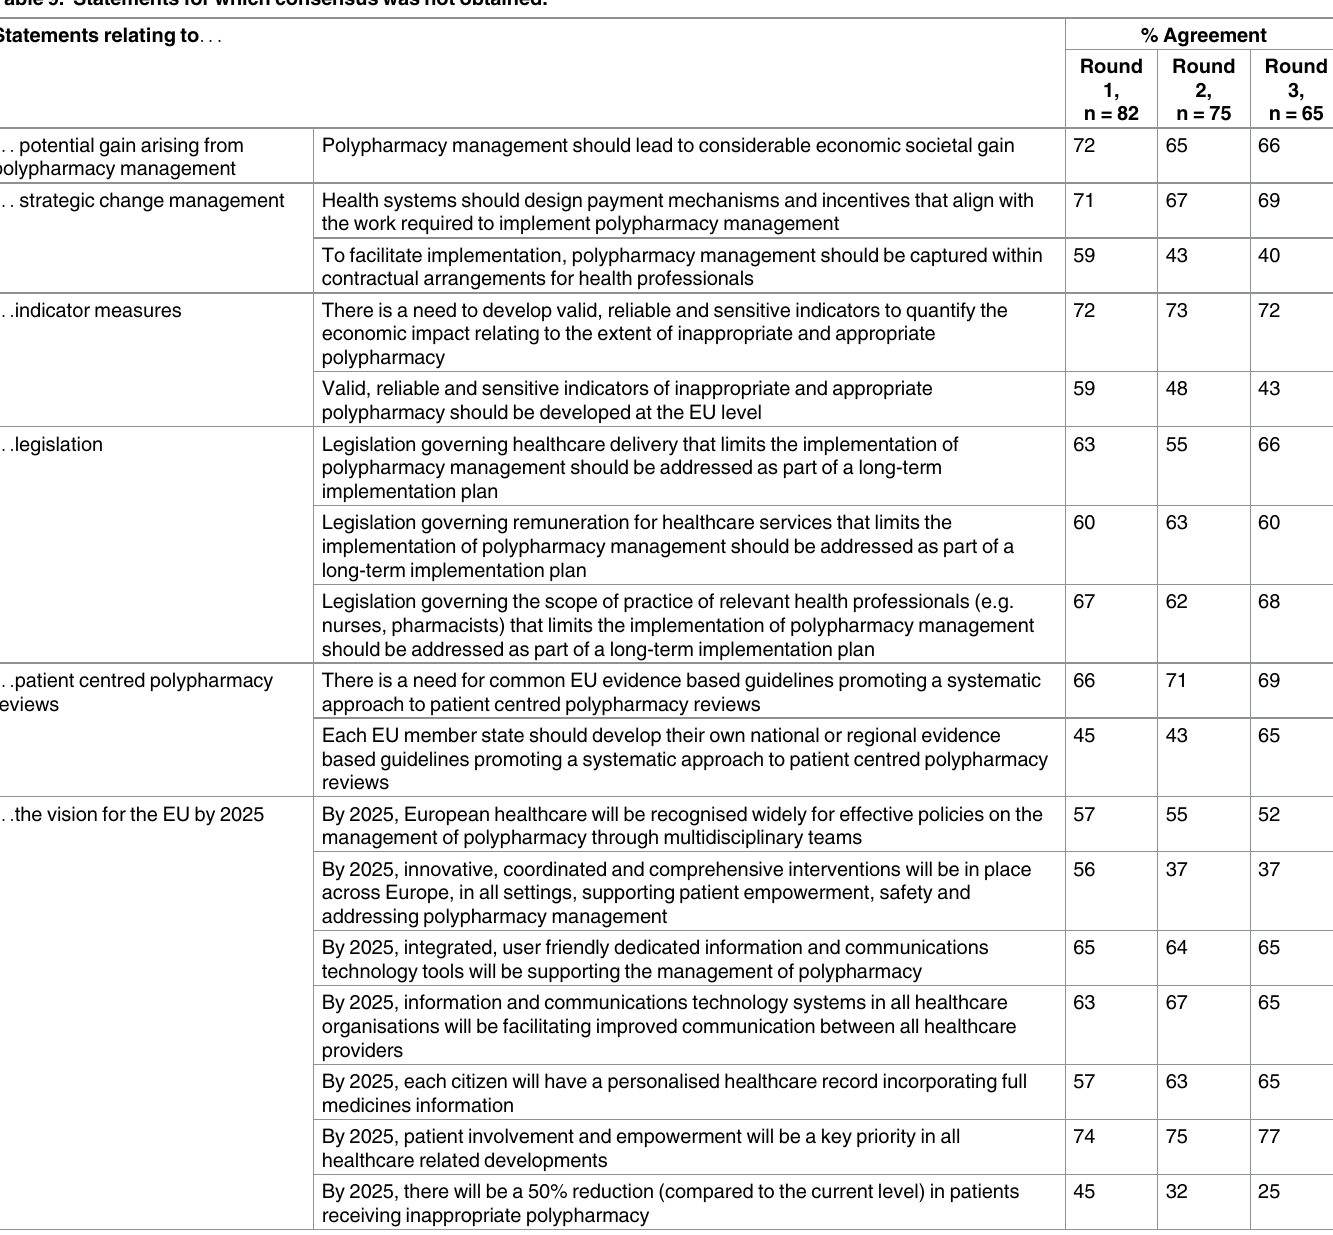
Table 9. Statements for which consensus was not